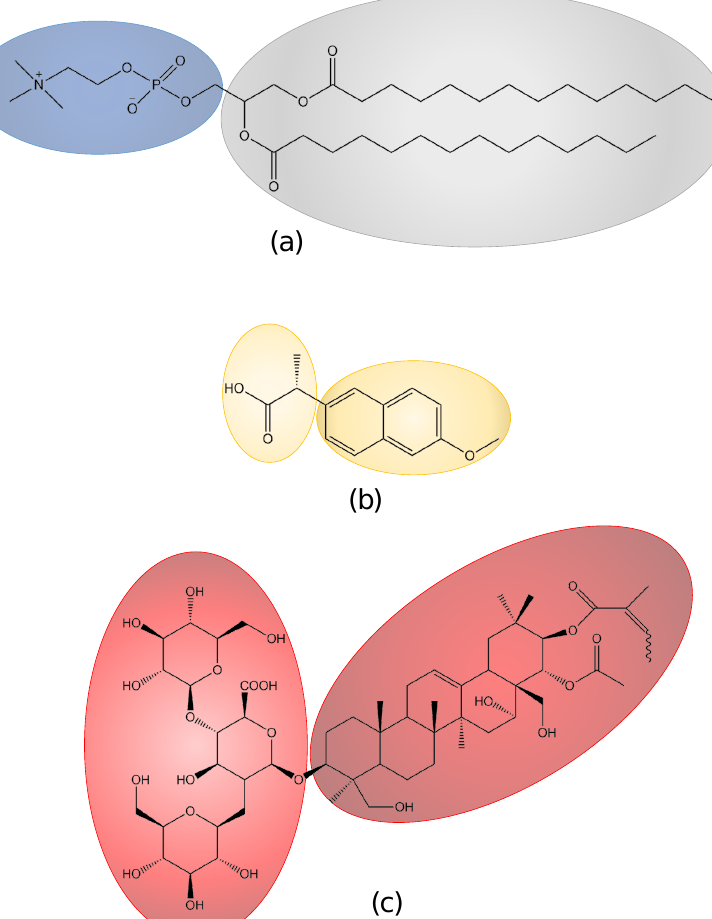
Figure 1. Chemical structures of ( a ) phospholipid DMPC, ( b ) NSAID naproxen, and ( c ) saponin β